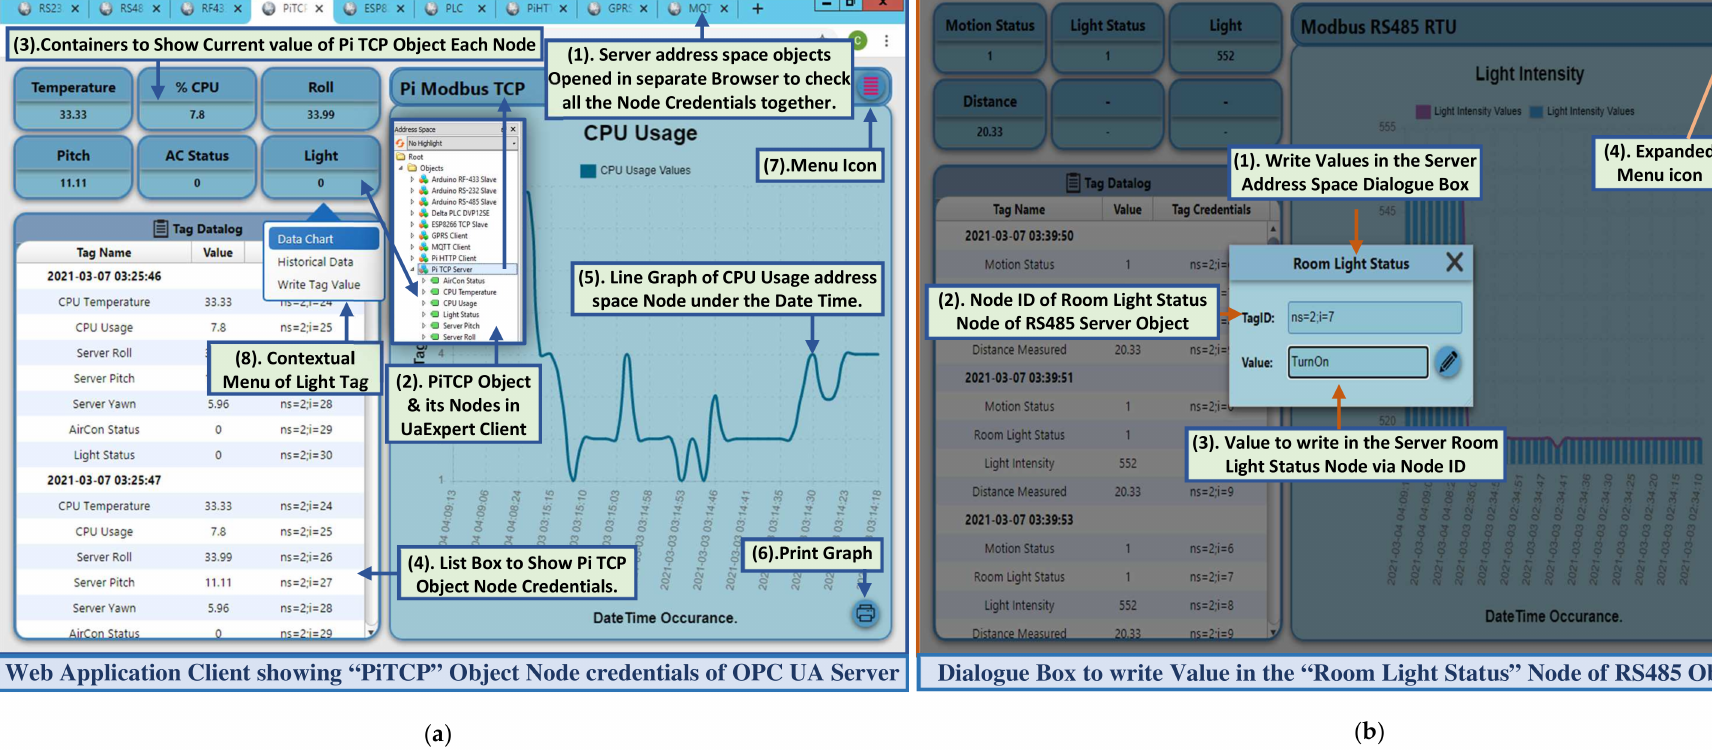
Figure 9. Web client GUI: ( a ) ‘PiTCP’ dashboard; ( b ) writing value in the server address space